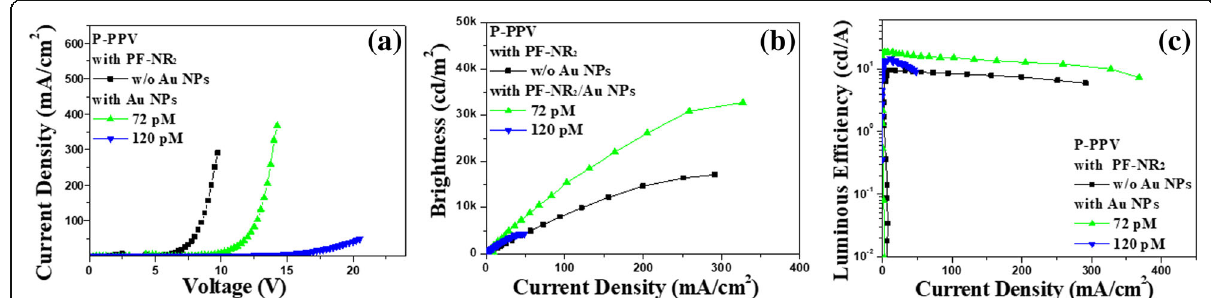
Fig. 7 a Current density vs. applied voltage (I-V). b brightness vs. current density (B-I), and c luminous efficiency vs. current density (LE-I) curves under different conditions when P-PPV was used as emitting layer in iPLEDs,